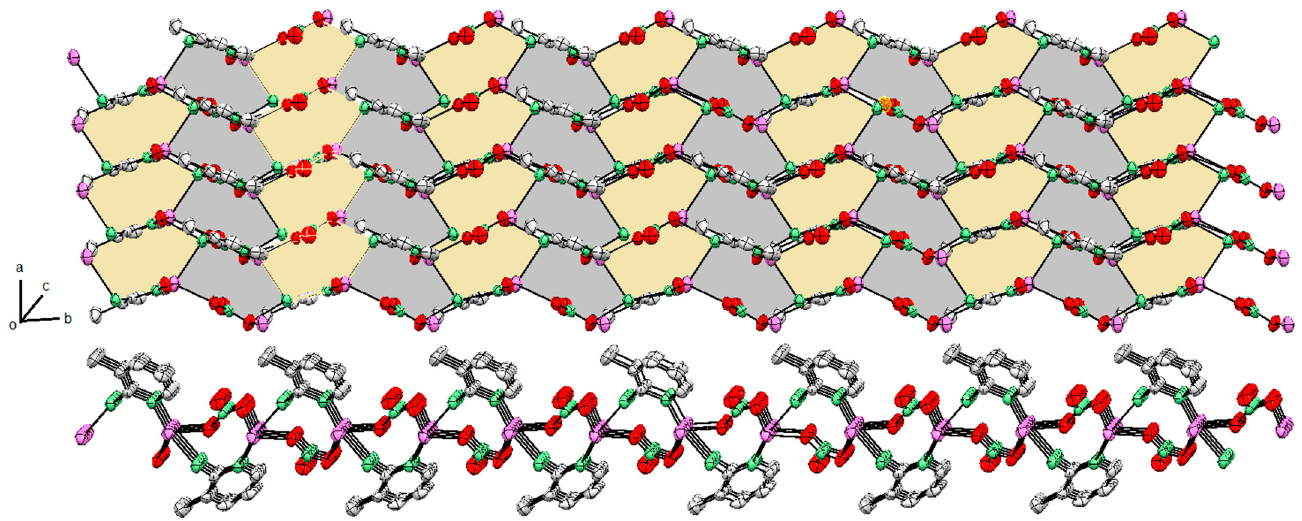
Figure 5. 2D polymeric structure (di ff erent views) of the complex 4, extended along a, b through nitrate and 2-aminopyridine moieties.